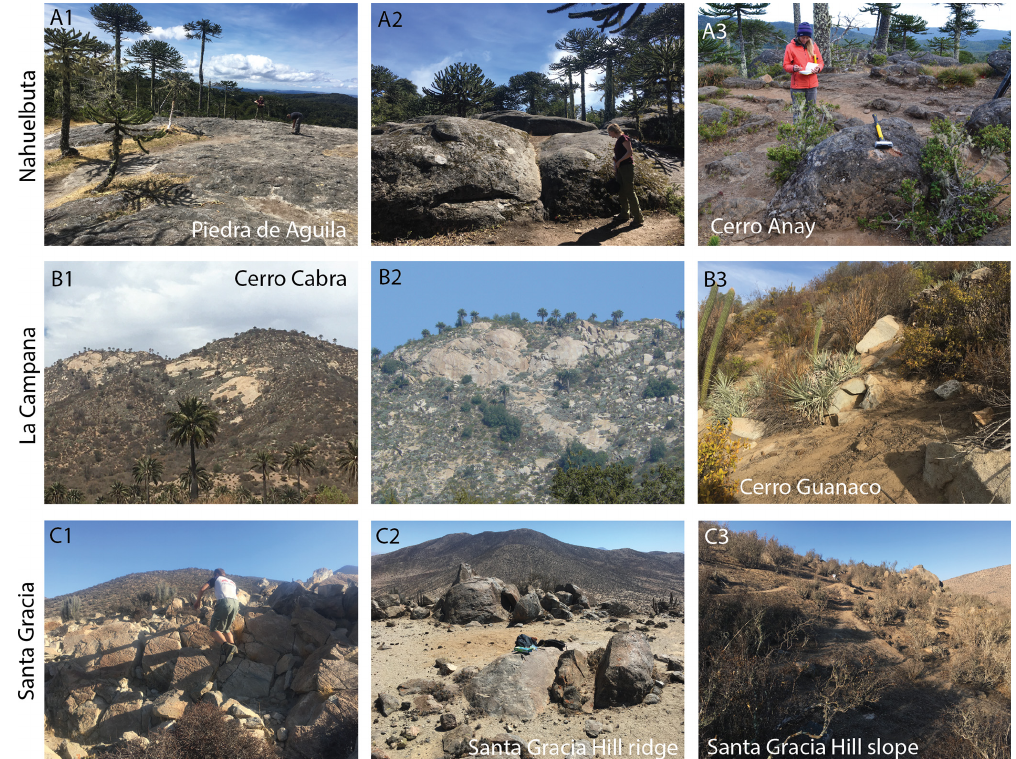
Figure 2. Field photos showing the various surfaces sampled, including bedrock, boulders, and soil. Figure panels are grouped by field site. (a) Nahuelbuta, (a1) bedrock (sample NB-BR1). (a2) Fractured bedrock, in transition between unfractured bedrock and boulders (sample NB- BR2). (a3) Smaller boulders surrounded by soil (sample NA7). (b) La Campana, (b1) bedrock (sample LC-BR2). (b2) Bedrock transitioning to large boulders and soil. (b3) Boulders and soil on a hillside (samples LC13 and LC14). (c) Santa Gracia, (c1) boulders on Zebra Hill delineated by fractures. (c2) Large boulders on the ridge of Santa Gracia Hill (sample SG8). (c3) Soil with minimal boulders on the slope of Santa Gracia Hill (samples SG22 and